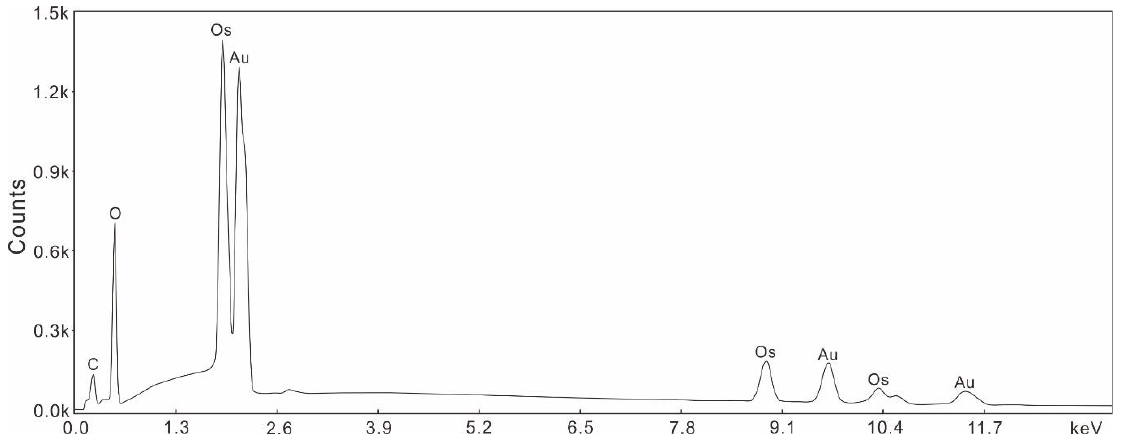
Figure 1. Representative EDS analysis of OsO 2 adhered to the inner surface of the gold capsule. Note that Au is derived from the gold capsule.